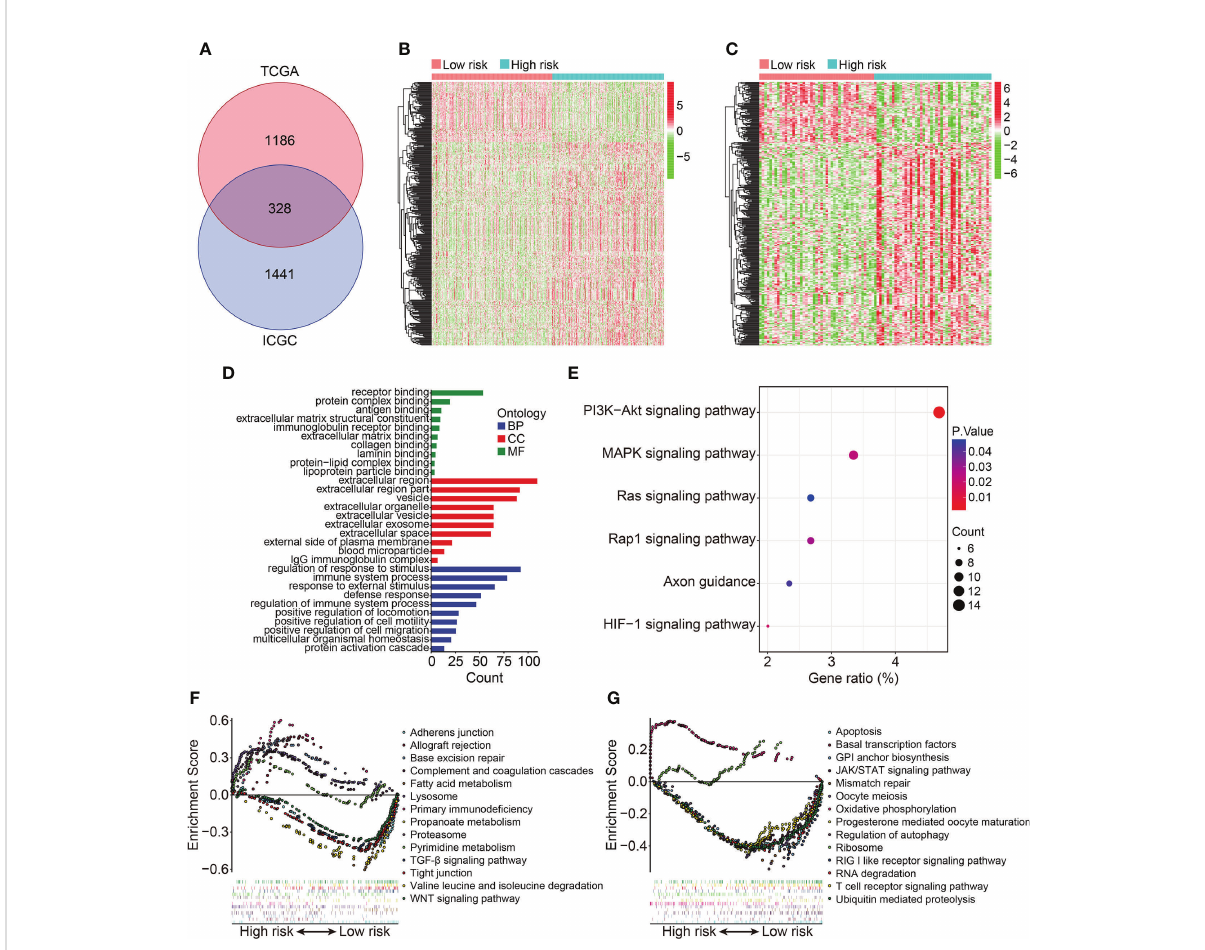
FIGURE 7 Identi fi cation of risk-related differentially expressed genes and functional enrichment analysis. (A) Venn plot exhibiting shared DEGs between different risk groups in TCGA and ICGC cohorts. (B, C) Heatmap showing the expression pro fi les of the DEGs in TCGA and ICGC cohorts. (D, E) GO and KEGG enrichment analyses. (F, G) Gene set enrichment analysis in TCGA and ICGC